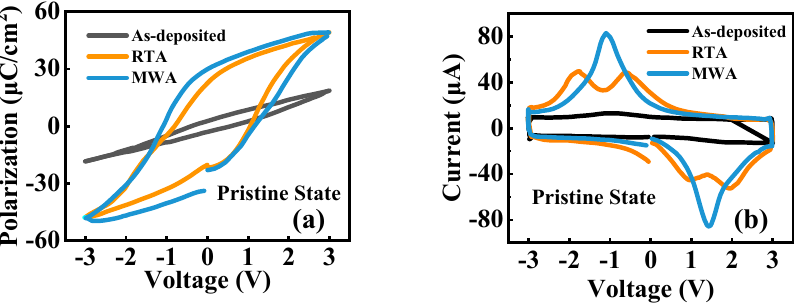
Figure 1. Ferroelectric characteristics of the as-deposited, RTA, and MWA devices. ( a ) P-V hysteresis loop plot. ( b ) I-V characteristics.